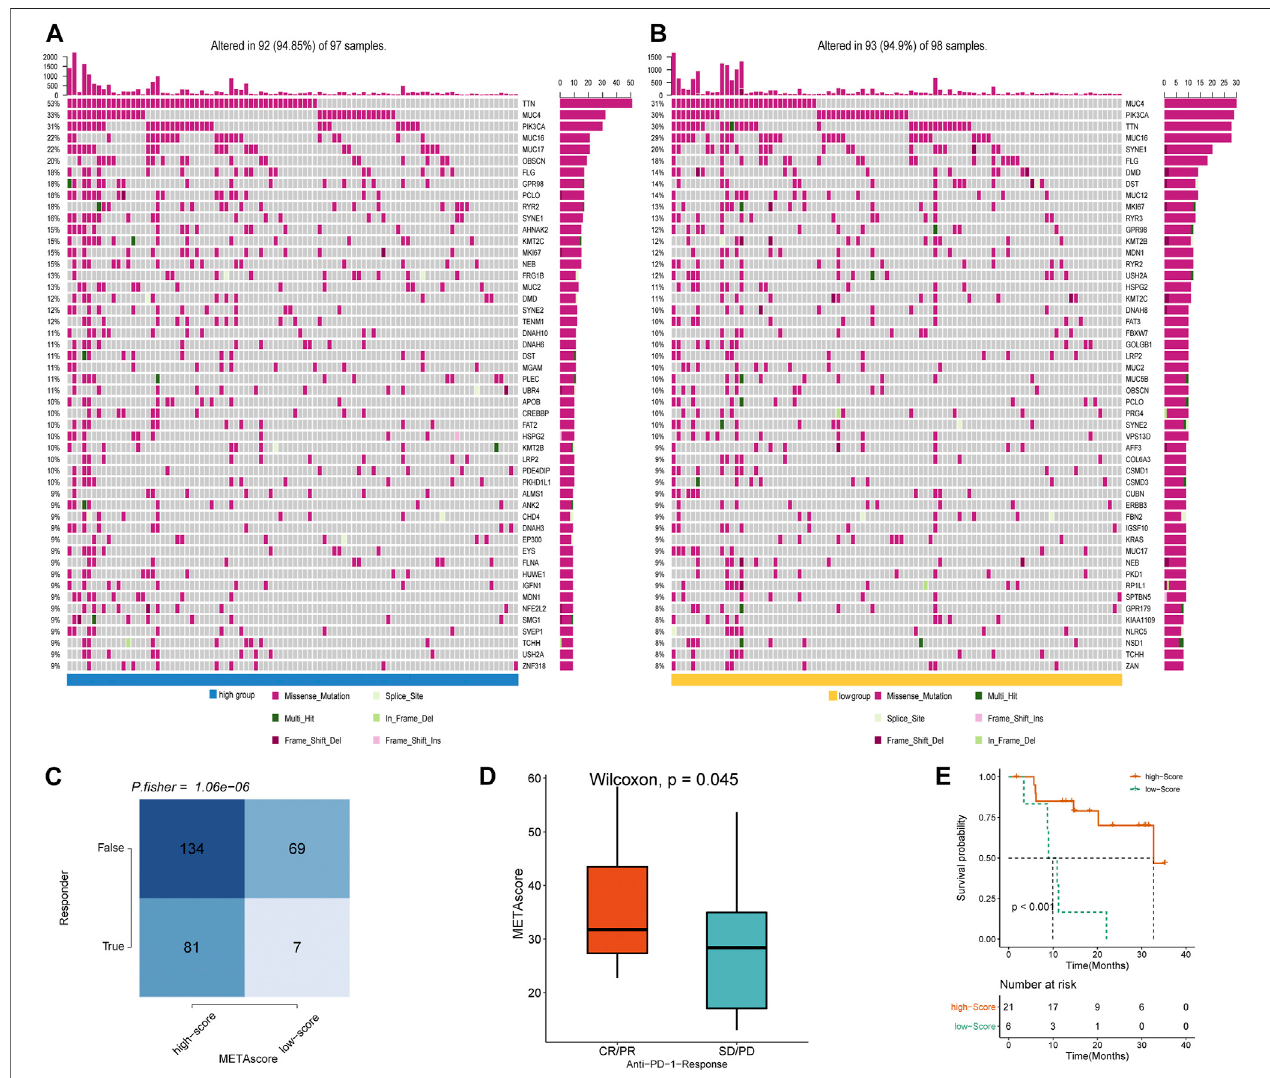
FIGURE 7 | METAscore predicts immunotherapeutic bene fi t. (A – B) The oncoPrint established by CESC patients with high-METAscore (A) and low- METAscore (B) . (C) TIDEpredictionbetweenhigh-andlow-METAscoregroup. (D) Rateofclinicalresponse(completeresponse[CR]/partialresponse[PR]andstabledisease[SD]/ progressive disease [PD]) to anti – PD-L1 immunotherapy in high- or low- METAscore groups in the GSE78220 cohort. (E) Kaplan – Meier curves for survival of patients with high- ( n (cid:1) 21) and low- ( n (cid:1) 6) METAscore in the GSE78220 cohort. Log-rank test presented an overall p < 0.001.